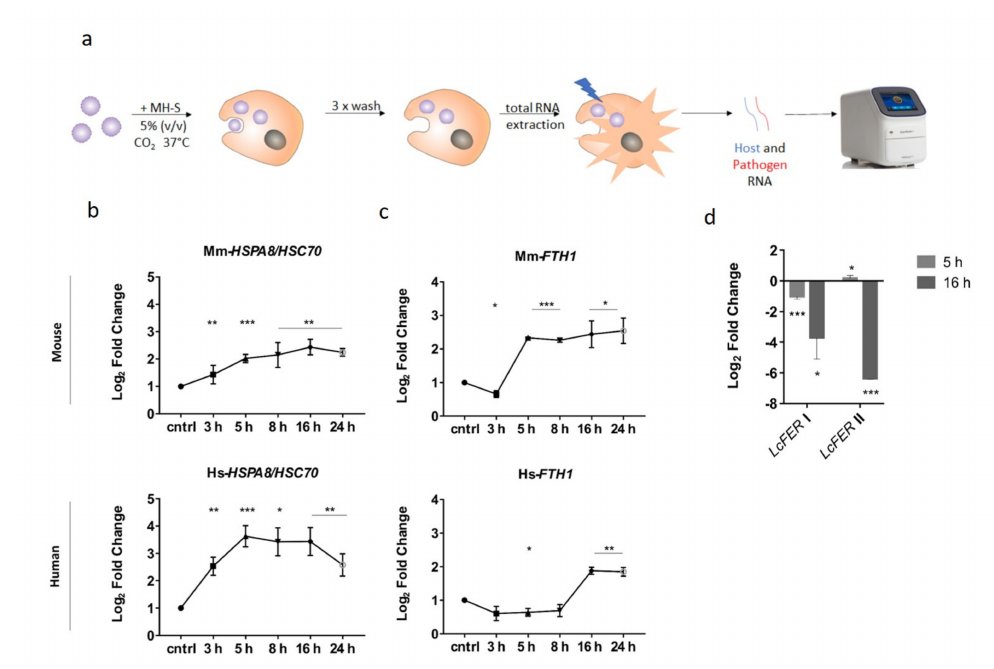
Figure 5. Expression profile of host protein Hspa8 ( HSPA8 ), iron storage ( FTH1 ) in macrophages and L. corymbifera during interaction for 24 h. ( a ) Schematic representation of workflow used for host pathogen interaction and gene expression validation. ( b ) Expression profile of the murine alveolar macrophage (MH-S) protein Hspa8 ( HSPA8 ) and human Hspa8 protein ( HSPA8 ) during interaction with L. corymbifera spores. ( c ) Expression pattern for host iron storage genes ( FTH1 ) in murine alveolar macrophages (MH-S) and human macrophages. (d ) Changes in gene expression for the putative copies for iron storage Ferritin ( FER I and FER II) of L. corymbifera . Data are means and standard error of three independent experiments. Asterisks indicates statistical significance determined by Student’s t-tests comparing treatment and control conditions at each time point (* p < 0.05; ** p < 0.01; *** p < 0.001).